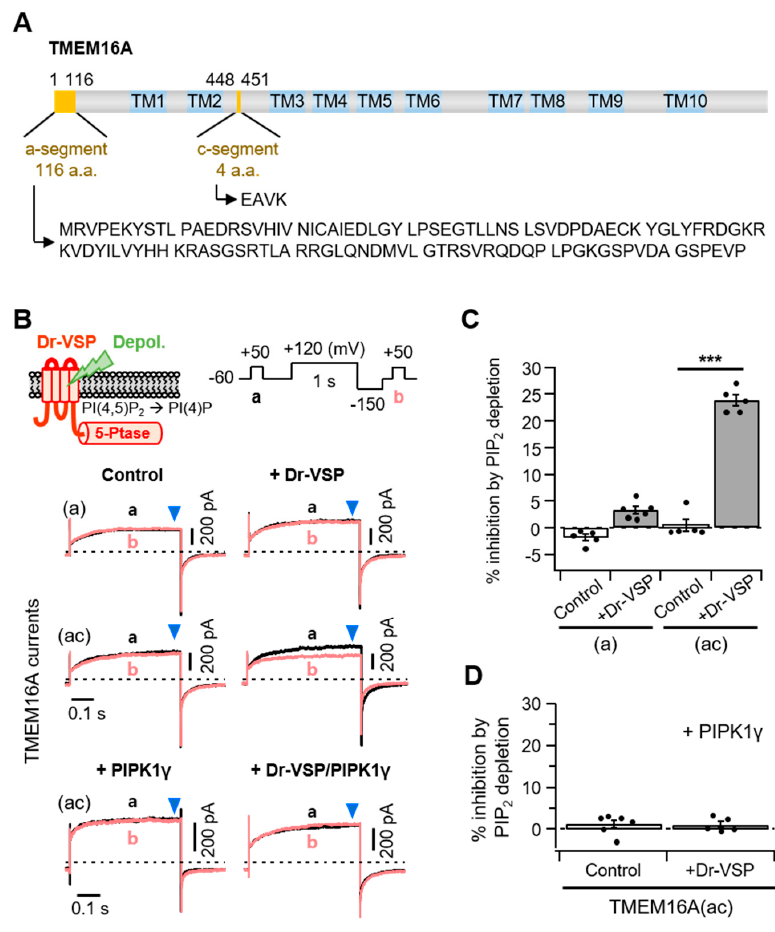
Figure 1. Different PI(4,5)P 2 sensitivities of alternatively spliced TMEM16A(a) and TMEM16A(ac) channels. ( A ) Domain-architecture schematics of the TMEM16A(ac) channel consisting of two splicing segments (yellow box) and 10 transmembrane domains (TM; blue box). The numbers above the diagram indicate the amino acid positions of two segments, “a” and “c”, in TMEM16A. The amino acid sequences for the alternatively spliced “a” (116 residues) and “c” (four residues) are shown below. ( B ) Top: An illustration of Dr-VSP-mediated PI(4,5)P 2 depletion in the plasma membrane. The inset shows the voltage protocol with a large depolarization for activating the Dr-VSP. Bottom: A comparison between the inhibition of TMEM16A(a) and TMEM16A(ac) currents by membrane depolarization in the control and Dr-VSP-expressing cells. The currents at +50 mV before (a, black) and after (b, red) 1 s depolarizing pulses to +120 mV are superimposed. The pipette solution contained 3 mM ATP and 455 nM (TMEM16A(a)) or 115 nM (TMEM16A(ac)) [Ca 2+ ] i . ( C ) Summary of TMEM16A(a) and TMEM16A(ac) current inhibition (%) by membrane depolarization in the control and Dr-VSP-expressing cells. n = 5. *** p < 0.001, one-way analysis of variance (ANOVA) followed by Sidak’s post hoc test. ( D ) Summary of current inhibition (%) of TMEM16A(ac) by membrane depolarization in cells expressing PIPKI γ alone or Dr-VSP plus PIPKI γ . n = 5–6. Dots indicate the individual data points for each cell. Bars indicate means ± standard error of the mean (SEM).